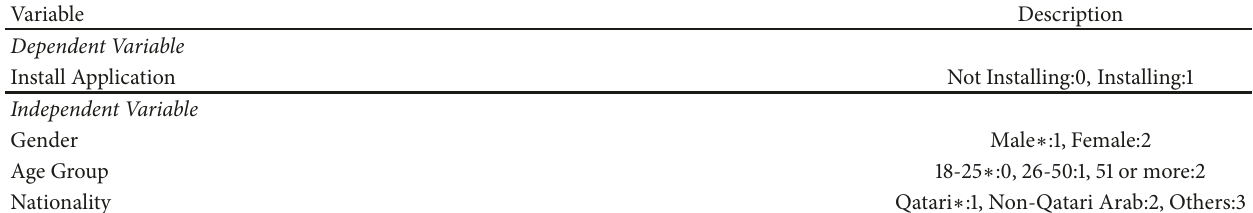
Table 2: Variable coding and